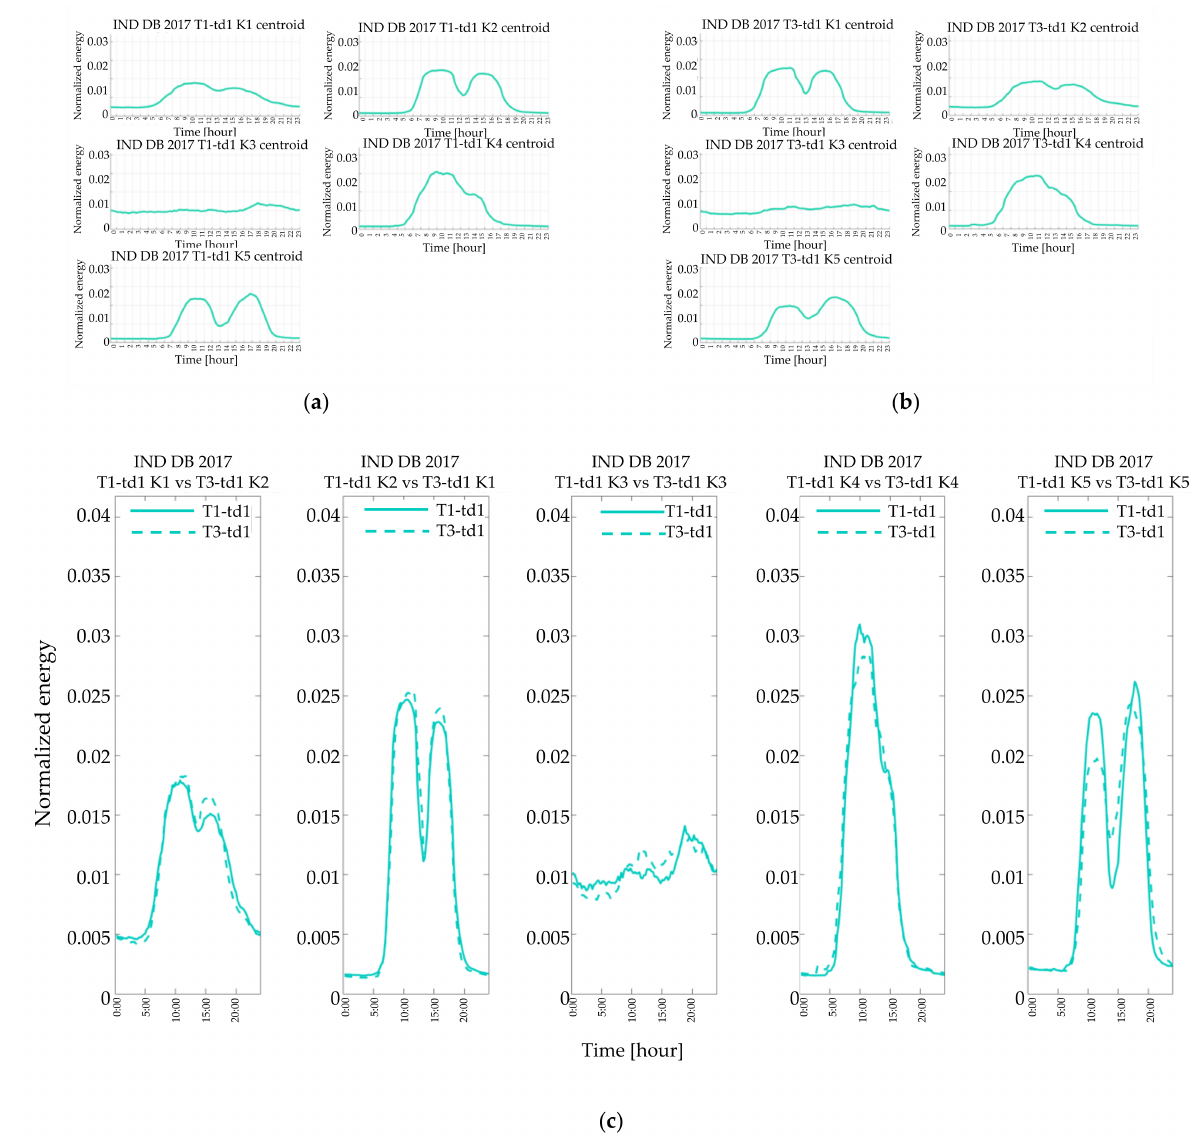
Figure 12. Database 2017, industrial (IND) end-users, normalized centroids: ( a ) winter workdays (five clusters), ( b ) summer workdays (five clusters), ( c ) comparison between the two typical days.